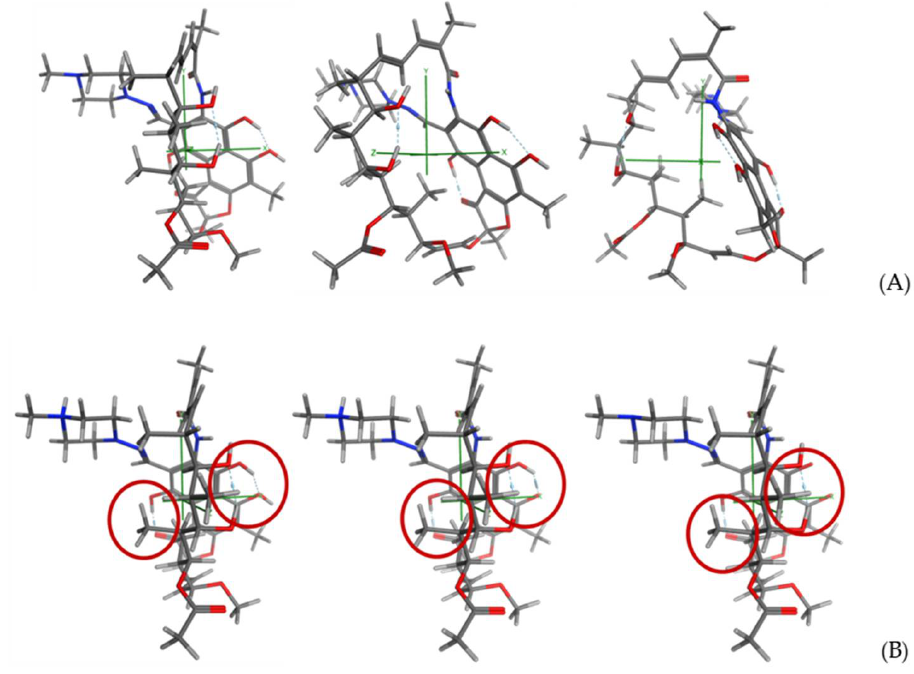
Figure 3. ( A ) 3D model for RIF showing the molecular axis. ( B ) Intramolecular hydrogen bonds framework (in red) for RIF at pH 4.0, 7.0, and 9.0 (lowest energy conformation).